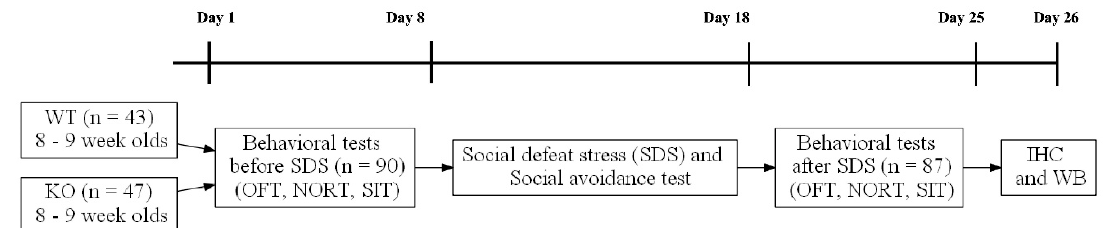
Figure 1. Experimental procedure.